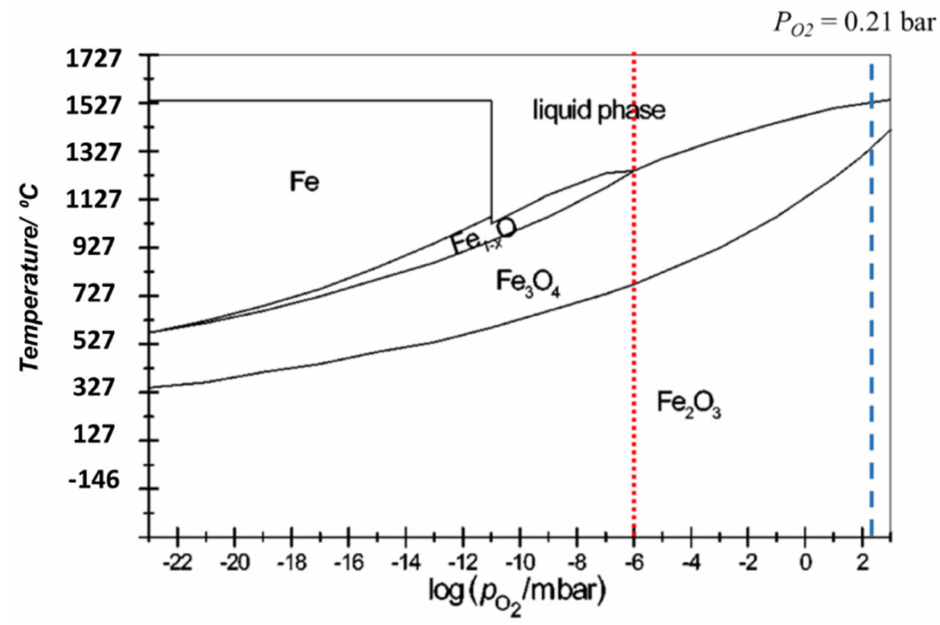
Figure 5. The stability phase diagram of iron and oxygen